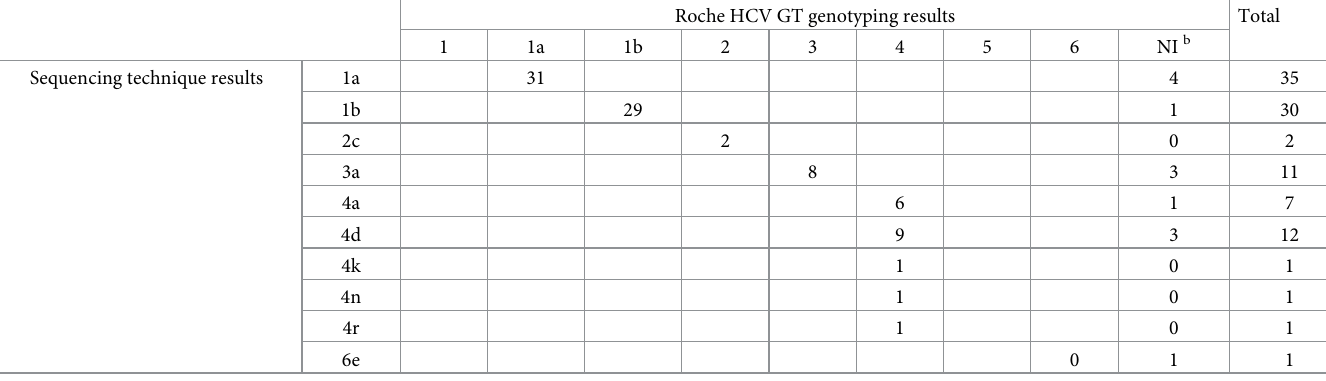
Table 2. Correspondence between results obtained with both techniques for the regular sample panel (n = 101).